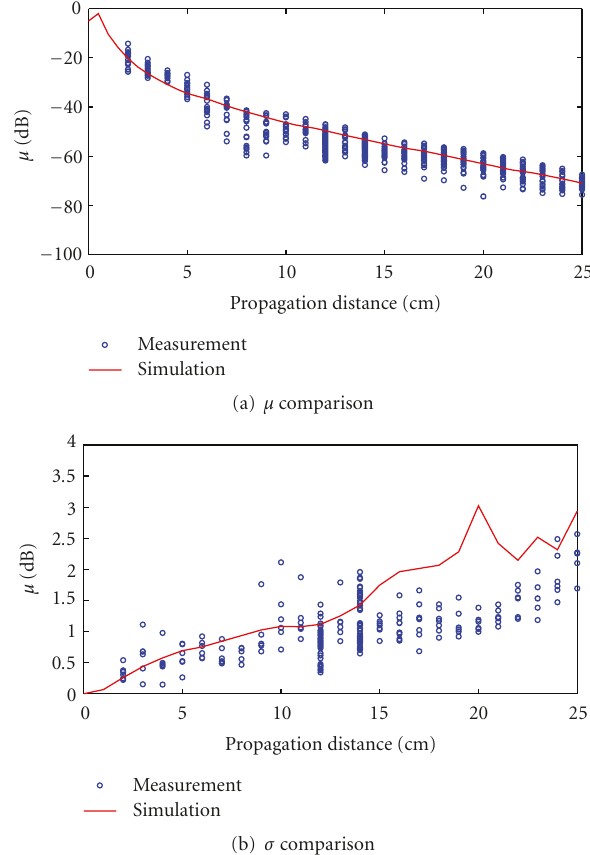
Figure 8: Comparisons of the mean ( μ ) and std ( σ ) of the channel fading amplitude (dB) for on-body channels around the trunk in tangential z